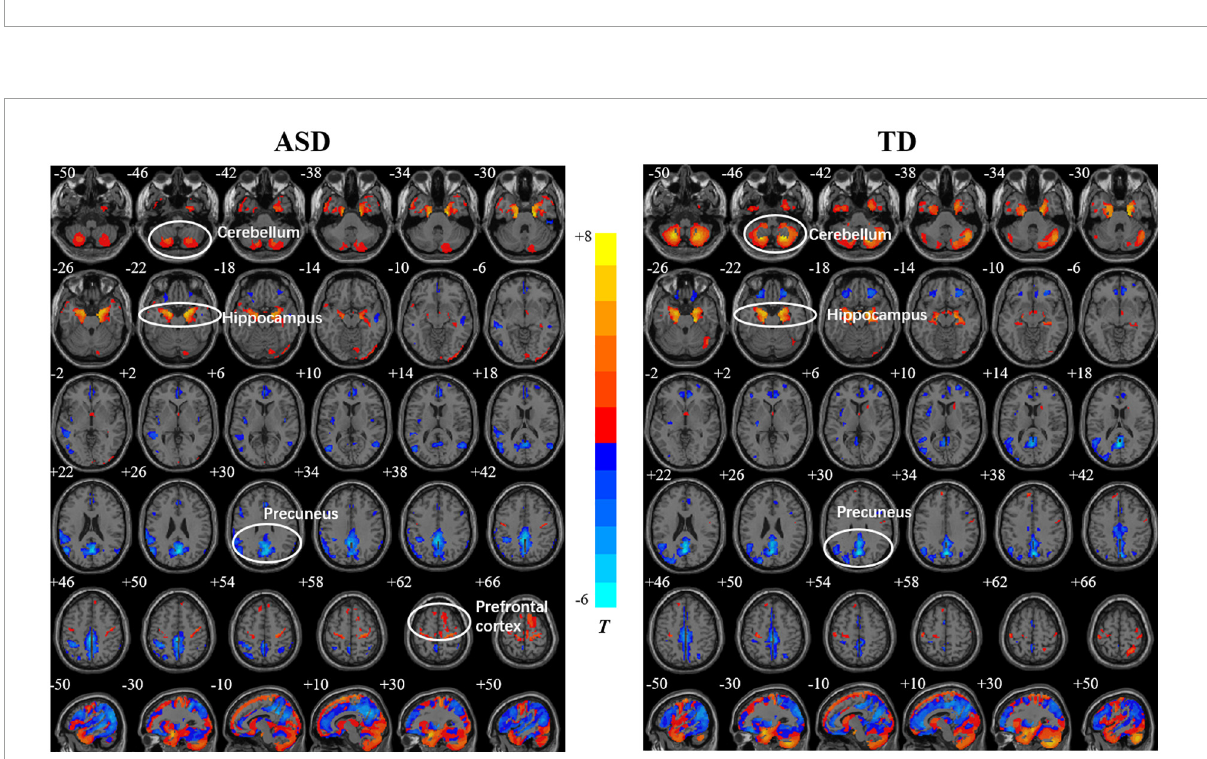
FIGURE2 Relationships between age and gray matter volume (GMV) in the autism spectrum disorder (ASD) and typically developing (TD) groups. The color bar shows the T value, in which warm and cold colors represent positive correlation and negative correlations,